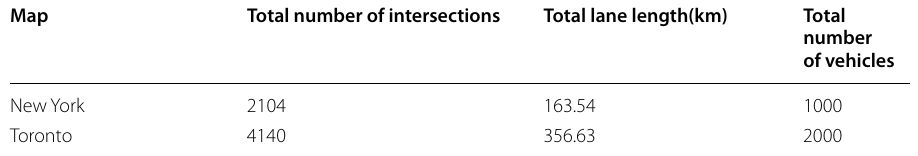
number of vehicles